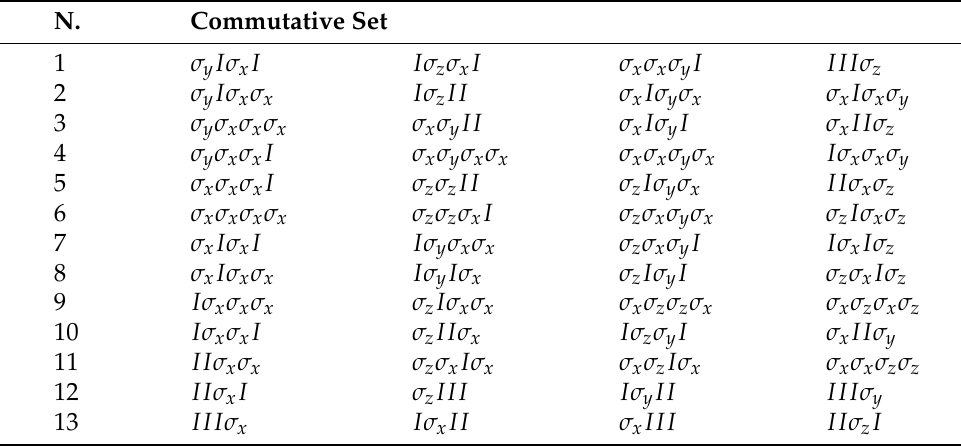
Table 7. Commutative sets (generators) whose eigenstates form a WUS of degree 13.